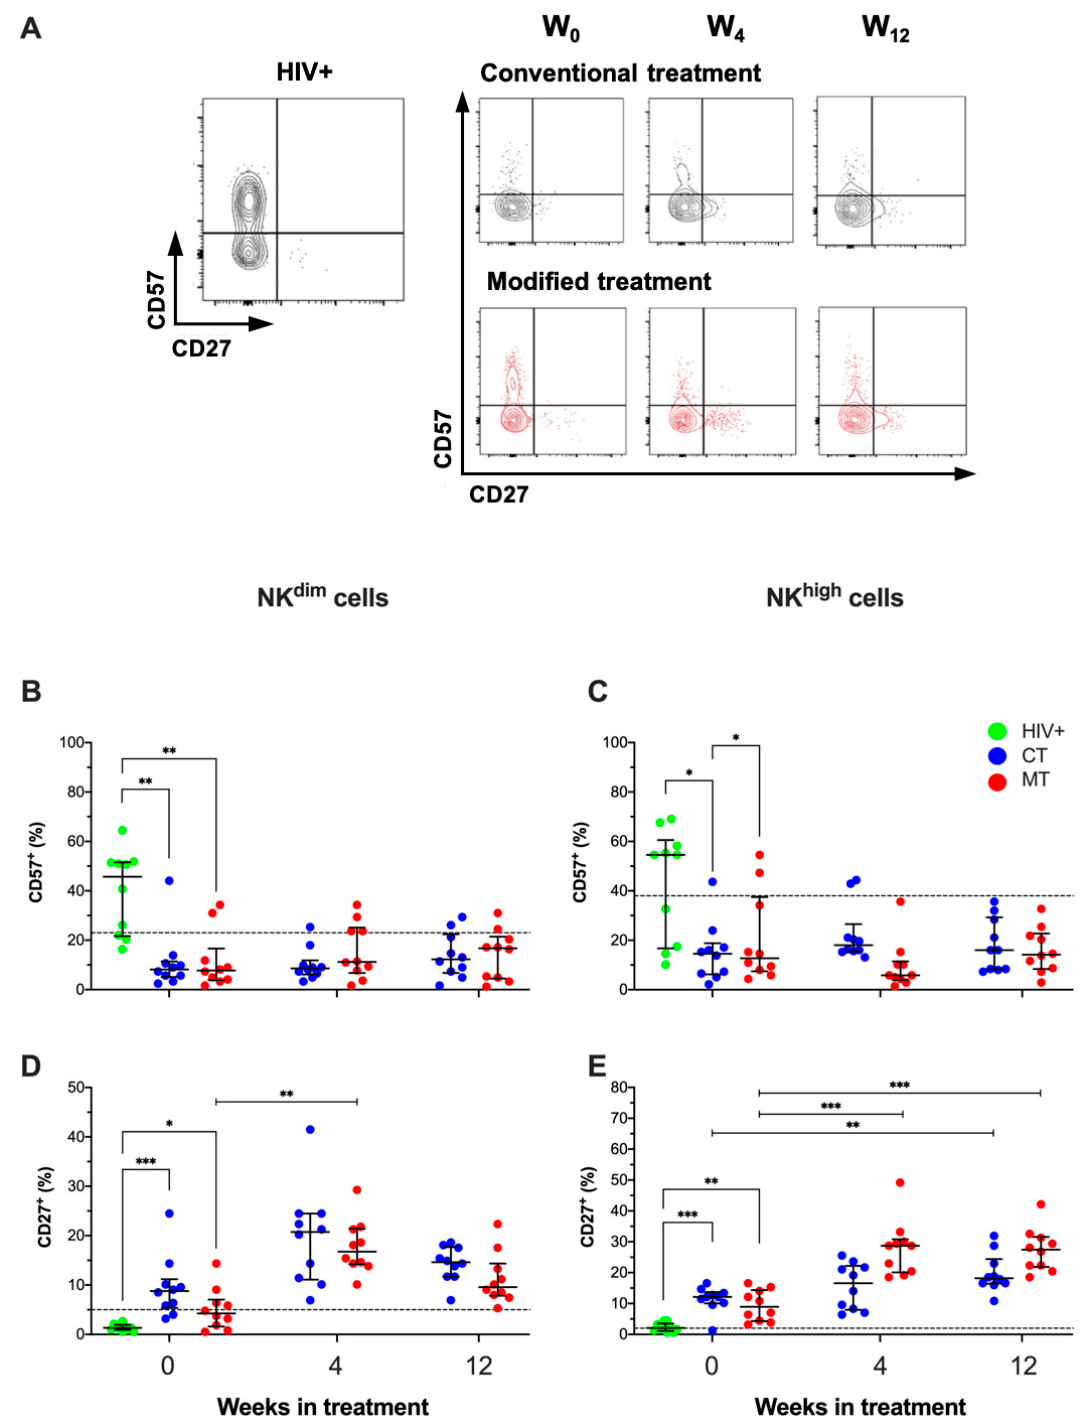
Figure 6. Differential expression of CD57 and CD27 on NK subsets depends on the treatment scheme in KS/HIV patients. ( A ) Representative density dot plots of NK cells expressing CD57 or CD27 in HIV+ and KS/HIV patients. Frequencies of CD57+ ( B , C ) and CD27+ ( D , E ) on both NK cells subsets were evaluated in HIV+ and KS/HIV patients across the follow-up weeks in each group. The black dashed line represents the median value of HIV-negative men. Green dots represent HIV+ asymptomatic men, blue dots represent CT and red MT participants. Statistical comparisons were performed using Kruskal–Wallis test, * p < 0.05, ** p < 0.01, *** p <